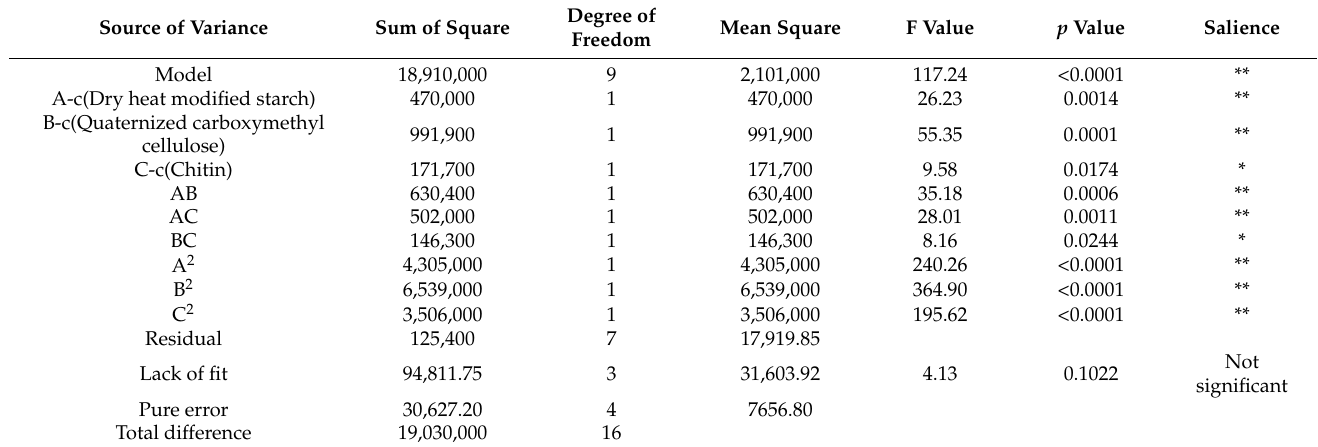
Table 2. Analysis of variance (ANOVA) of the test results for the swelling properties of hydrogels.